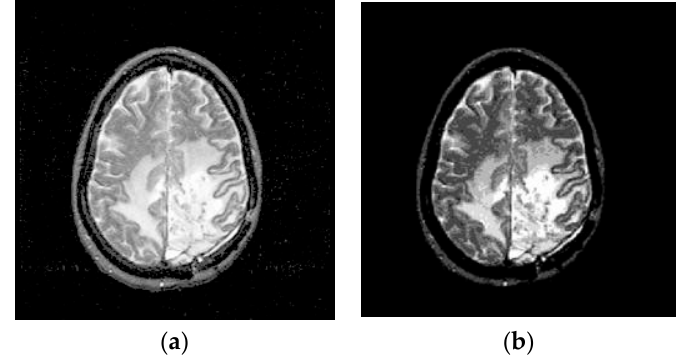
Figure 4. ( a ) Preprocessed image, ( b ) Processed image after Otsu threshold segmentation.